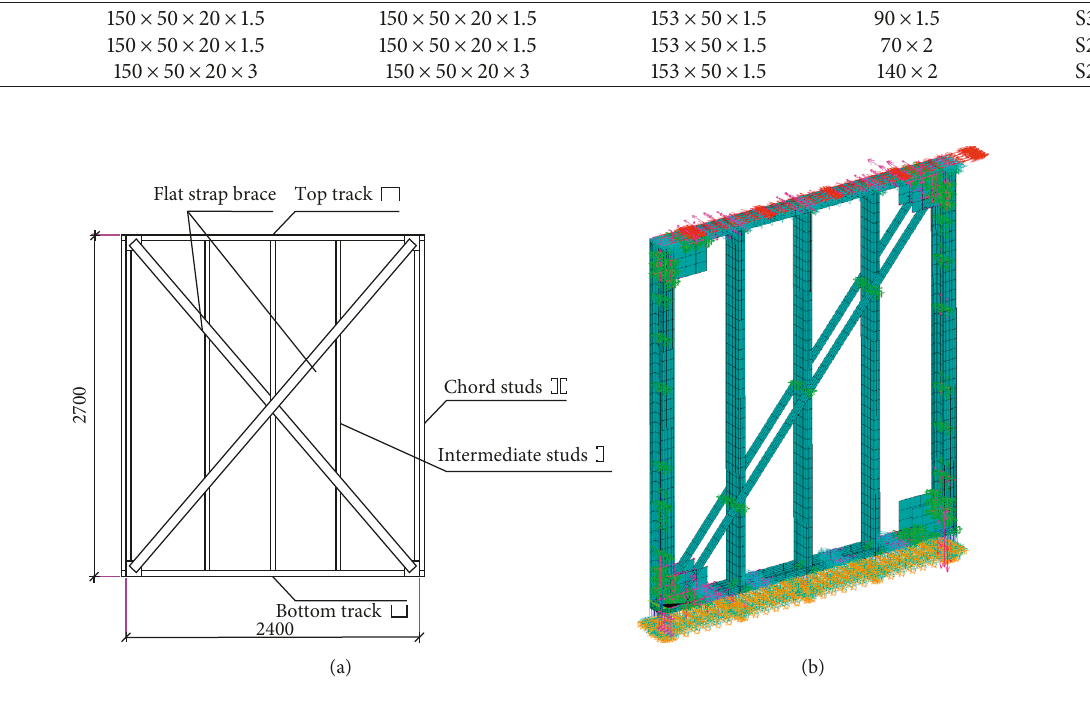
Figure 9: Wall setup